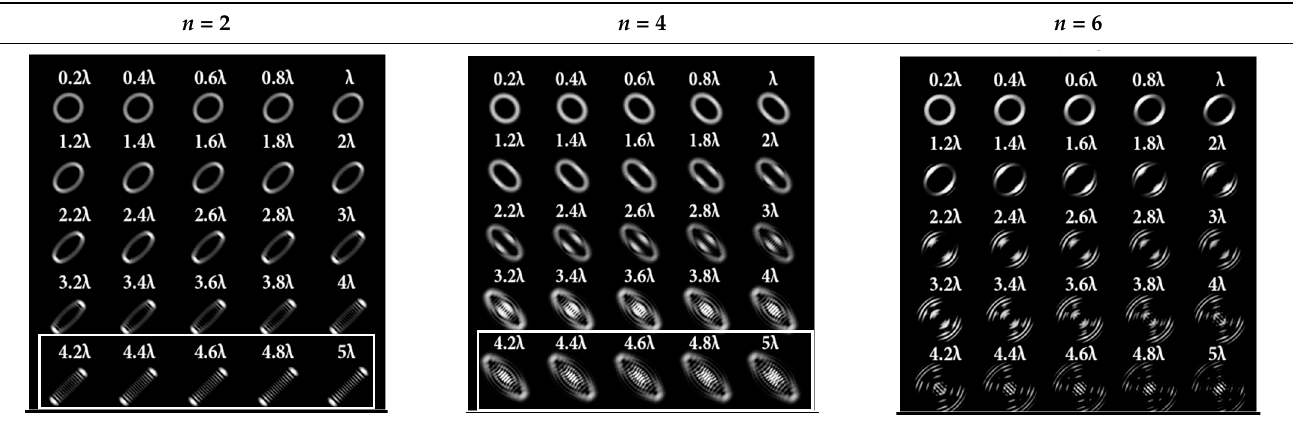
( , ) Z r ϕ ,2 n ( , ) Z r ϕ ( , ) Z r ϕ ( , ) Z r ϕ ,2 n ,2 ,2 n n